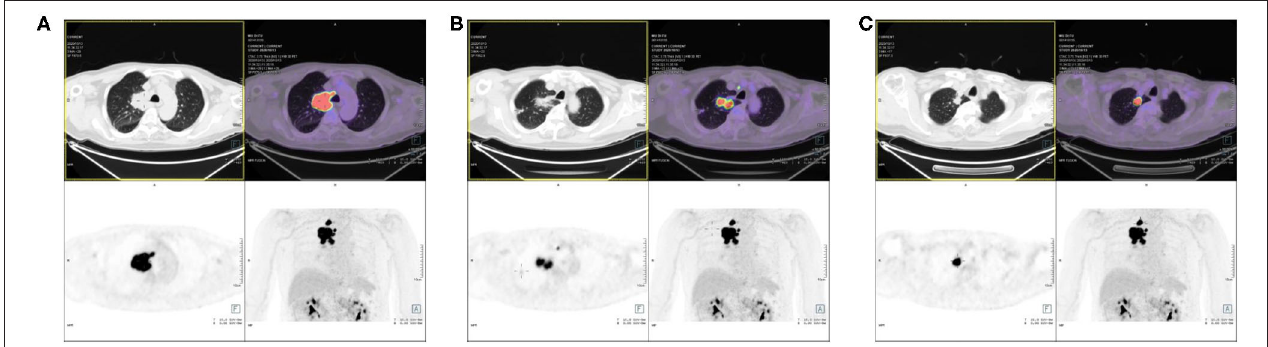
FIGURE 2 | Positron emission tomography (PET)/MRI of the patient. (A) The high metabolic mass in the upper right lobe. (B) The high metabolic nodule at the apex of the right lung. (C) The small nodules in the upper right lobe with traction of the adjacent pleura, with slightly increased